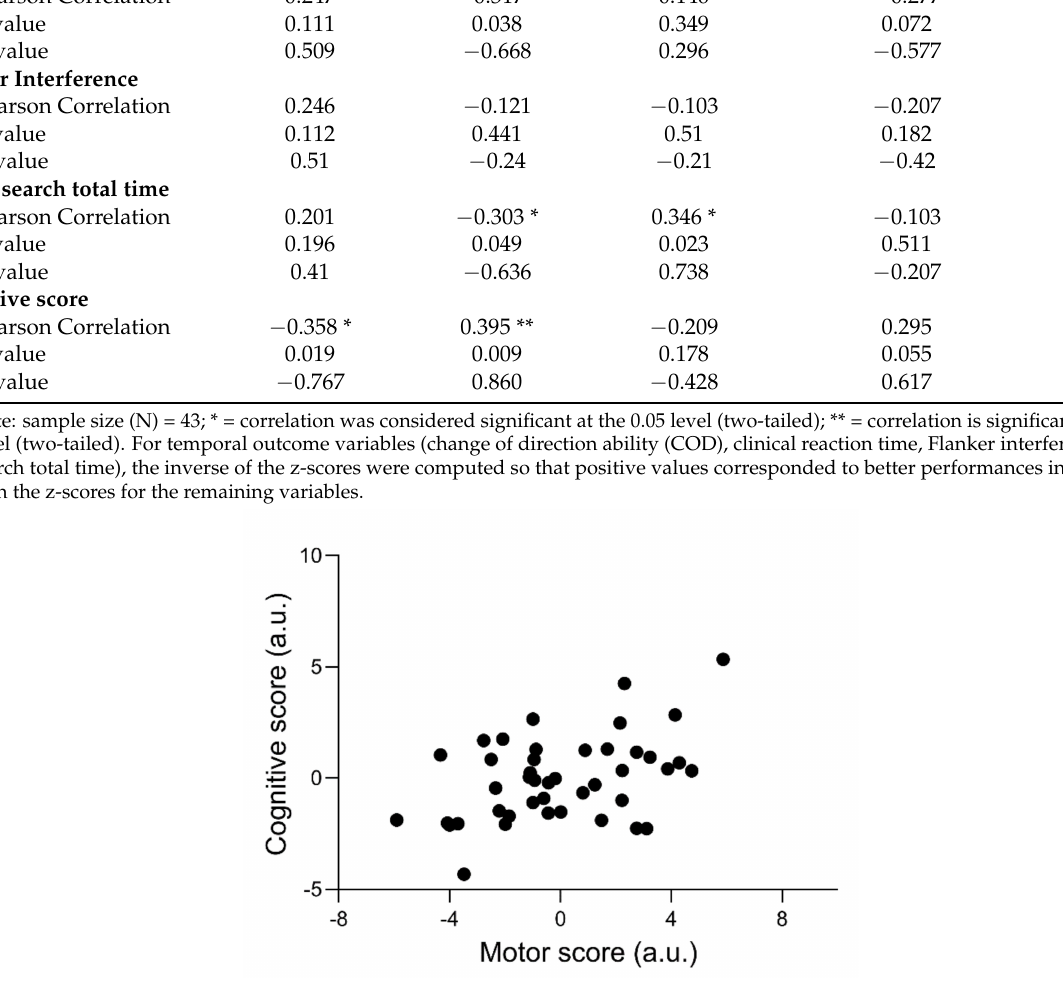
Figure 1. Scatterplot showing the relationship between cognitive score and motor score ( r = 0.451, p =